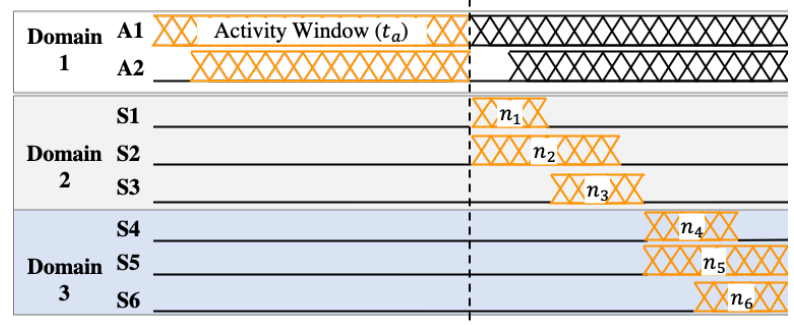
Figure 2. Timing information and activity window